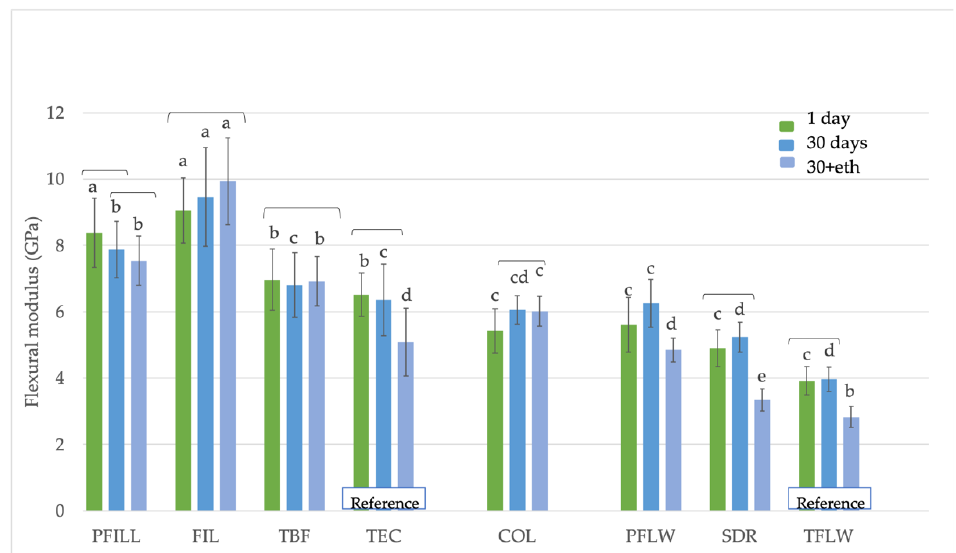
Figure 2. Flexural strength (MPa) of tested materials. Equal letters represent statistically homogene- ous groups for a particular time point. Parentheses indicate statistically similar groups for a partic- ular material. Dashed parentheses indicate statistically homogeneous groups within the same ma- terial, which are not similar to the column in between (in cases where the time dependence is not monotonous), p < 0.05.